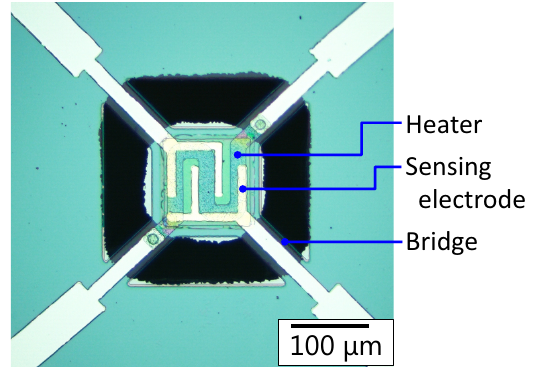
Figure 4. Optical microscopy image of the fabricated device.